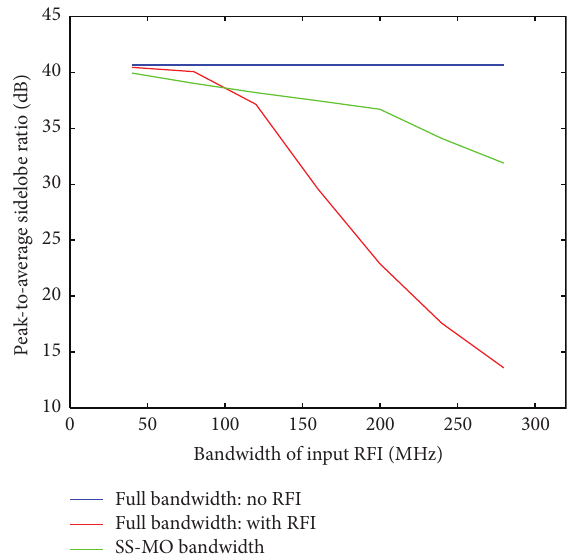
Figure 14: The PSLR results of the wideband RFI experiment. The PSLR measured for the SS-MO algorithm is maintained at a higher level as the narrowband interference power increases.